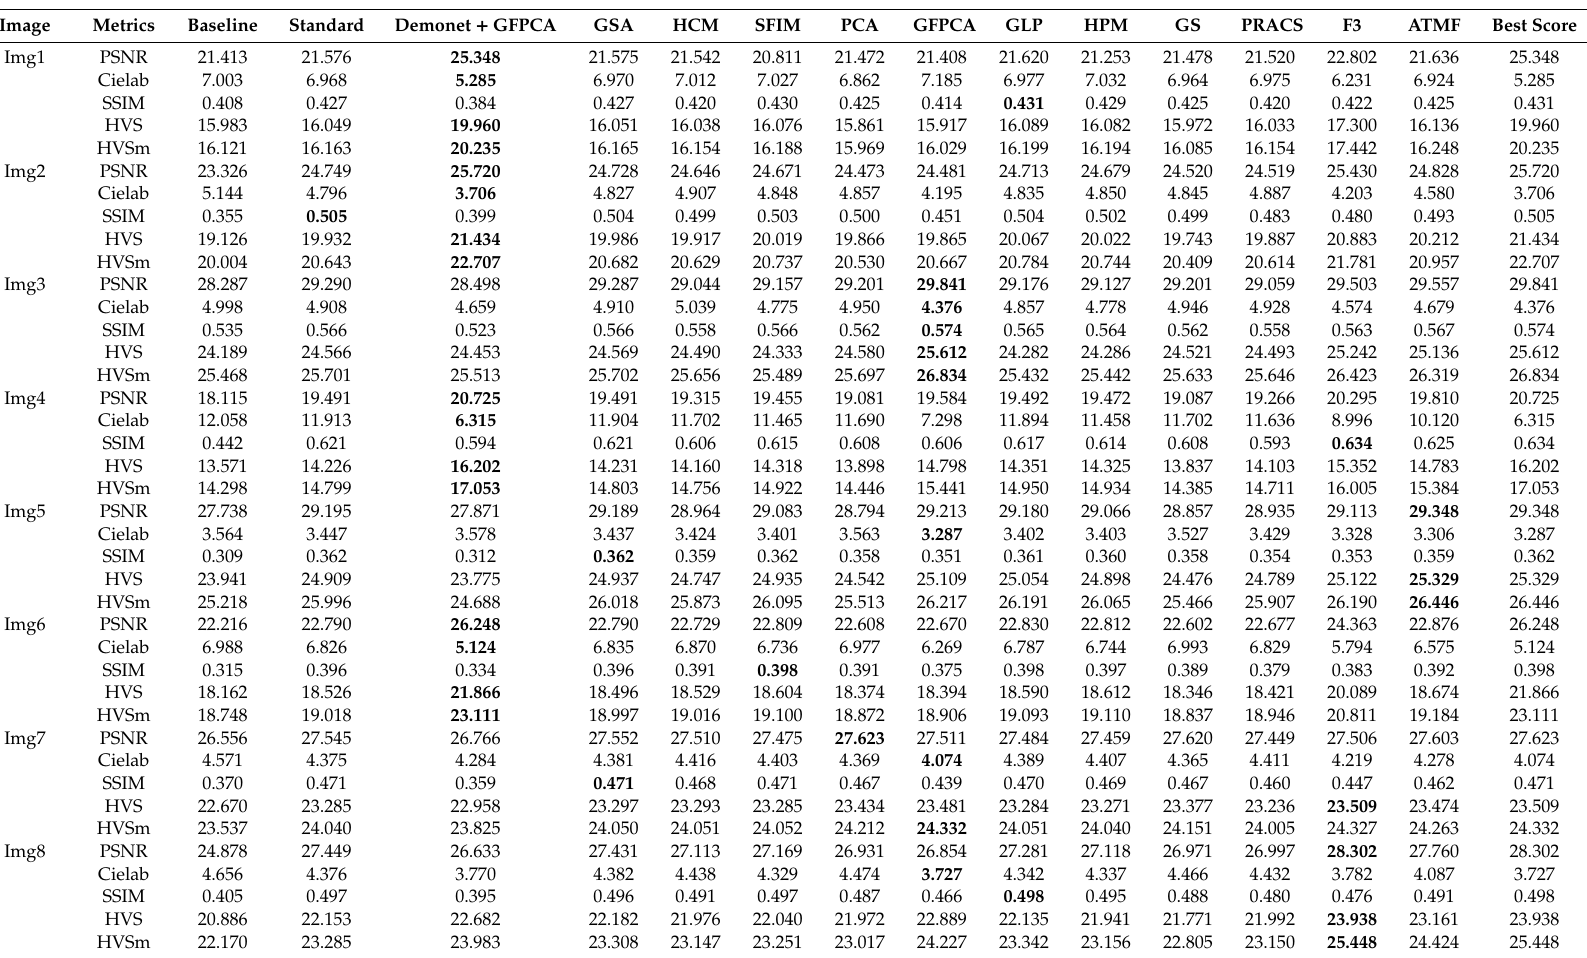
Table A5. Performance metrics of 14 algorithms at 10 dBs SNR (Poisson noise). Bold numbers indicate the best performing methods in each row. Red numbers indicate those methods used in F3 and those red and green numbers indicate those methods used in